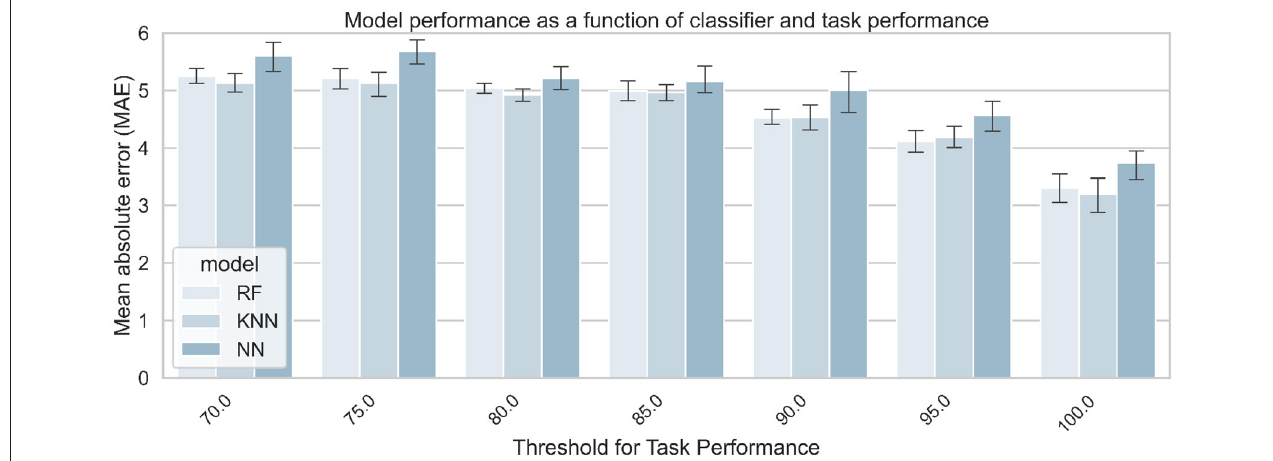
FIGURE 13 | Models’ performance for predicting MWL on a 0–20 scale, as a function of algorithm and task performance. The three signals (EDA + ECG + RESP) were used to train the classifiers.